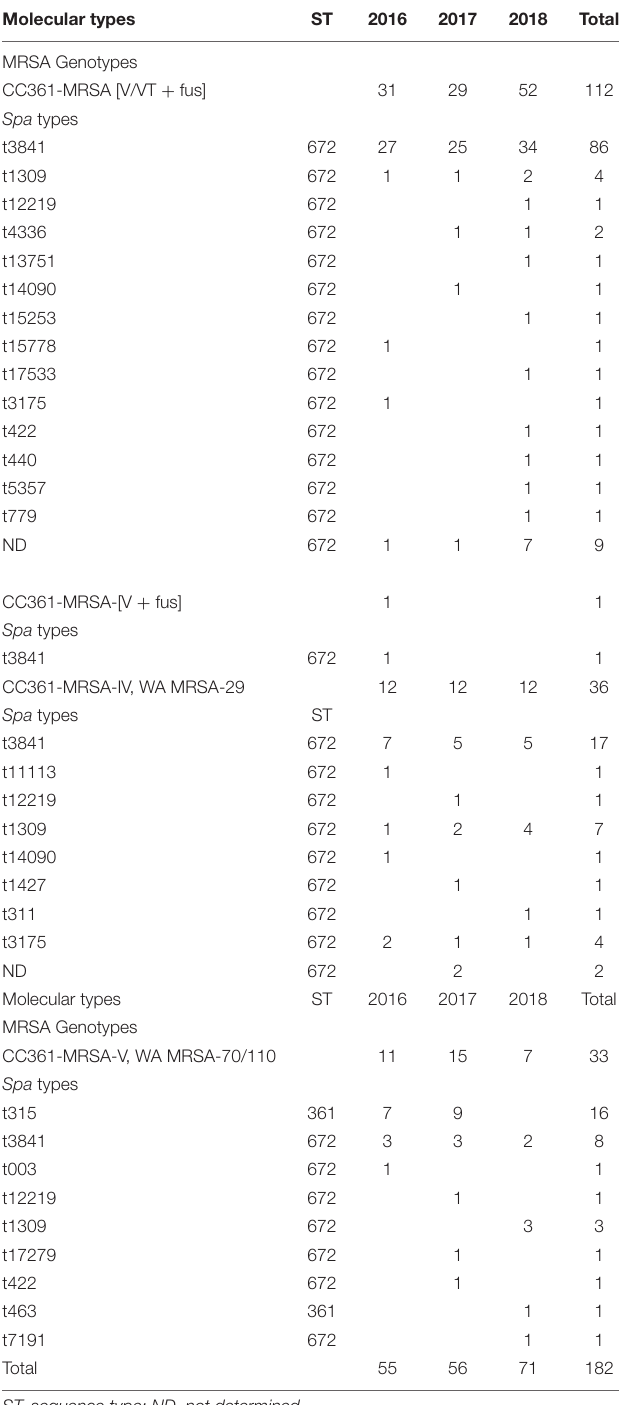
TABLE 1 | Molecular characteristics of CC361-MRSA isolates from 2016 to